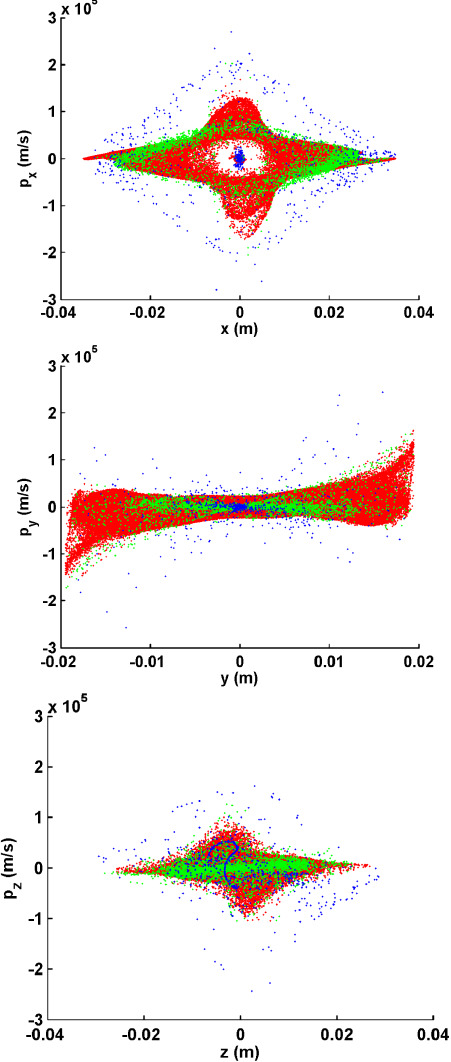
FIG. 11. Distribution of the ions in mixture 4 in phase space ( x , p x ) (top), ( y , p y ) (middle) and ( z , p z ) (bottom) after 5000 interactions with the electron bunch, CO þ — red, CH þ 4 — green, H þ 2 —